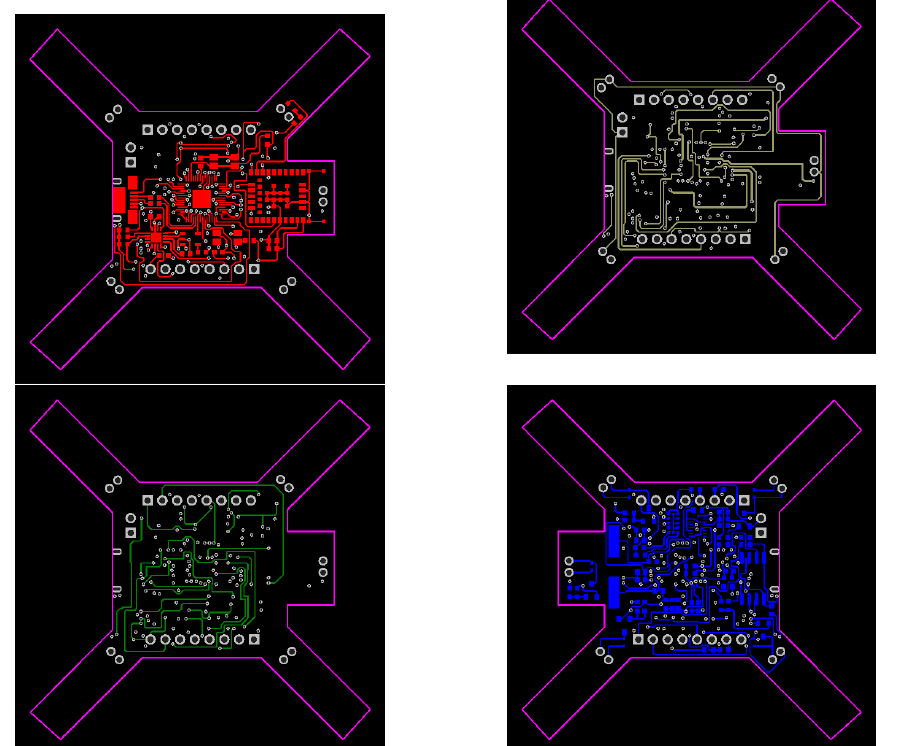
Figure 3. The four layers of the NAB’s PCB. (1) Top layer. (2) Inner 1 layer. (3) Inner 2 layer. (4) Bottom